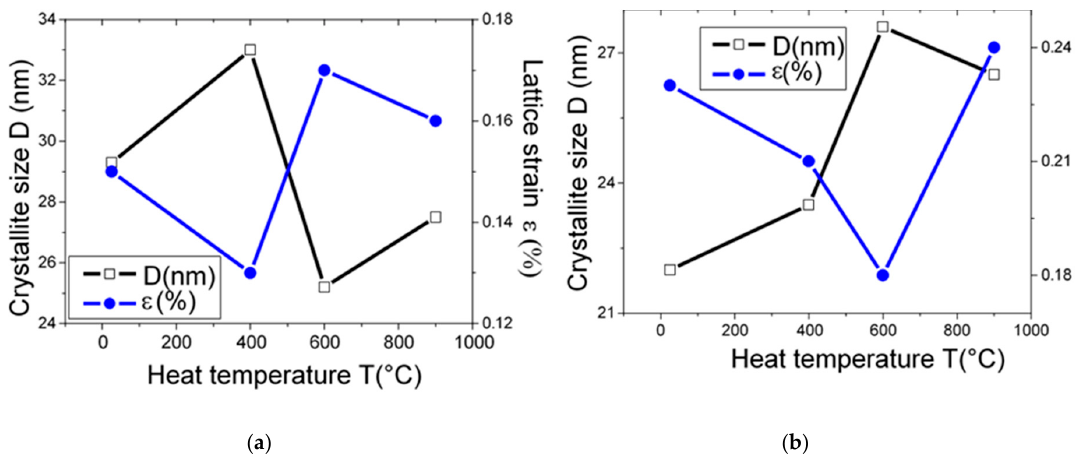
Figure 4. Crystallite size and lattice strain evolution as function of heat temperature: ( a ) quartz, ( b ) calcite.